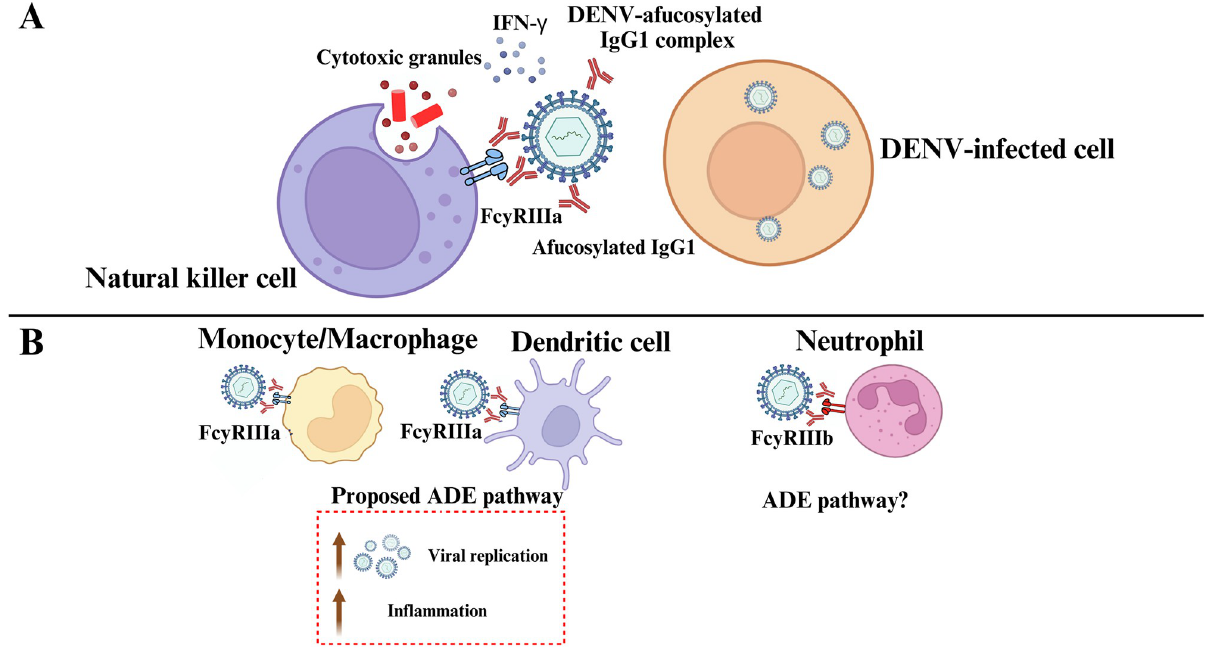
Fig 2. Proposed effector pathways in different immune cells following stimulation with afucosylated IgG1–DENV immune complexes. ( A ) NK cells highly express Fc γ RIIIa (CD16a) and may recognise afucosylated IgG1–DENV immune complex. This may then promote antibody-dependent cell-mediated cytotoxicity, leading to direct killing of DENV-infected cells and DENV, contributing to protection from symptomatic dengue. ( B ) Afucosylated IgG1s may promote extrinsic ADE in phagocytes, as the absence of fucose molecule greatly enhances the binding of afucosylated IgG1– DENV immune complex to Fc γ RIIIa expressed by monocytes/macrophages and dendritic cells. This may lead to immature virion uptake, maturation, and replication, leading to increased viremia and inflammation. Neutrophils express Fc γ RIIIb, and DENV-activated neutrophil can release potent antimicrobial molecules that are associated with severe dengue. However, whether interaction between afucosylated IgG1–DENV immune complex and Fc γ RIIIb results in ADE and/or release of potent antimicrobial is unknown. Further investigations are needed to provide evidence on afucosylated lgG1s involvement in the proposed pathways above. ADE, antibody-dependent enhancement; DENV, dengue virus; IgG, immunoglobulin G; NK, natural